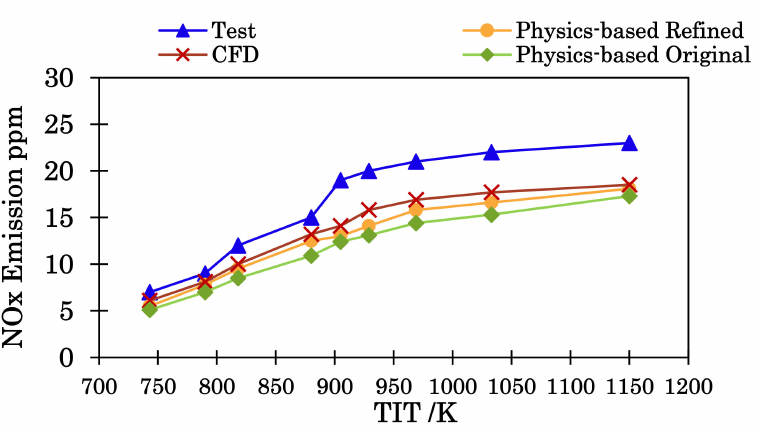
Figure 16. NOx results comparisons at different